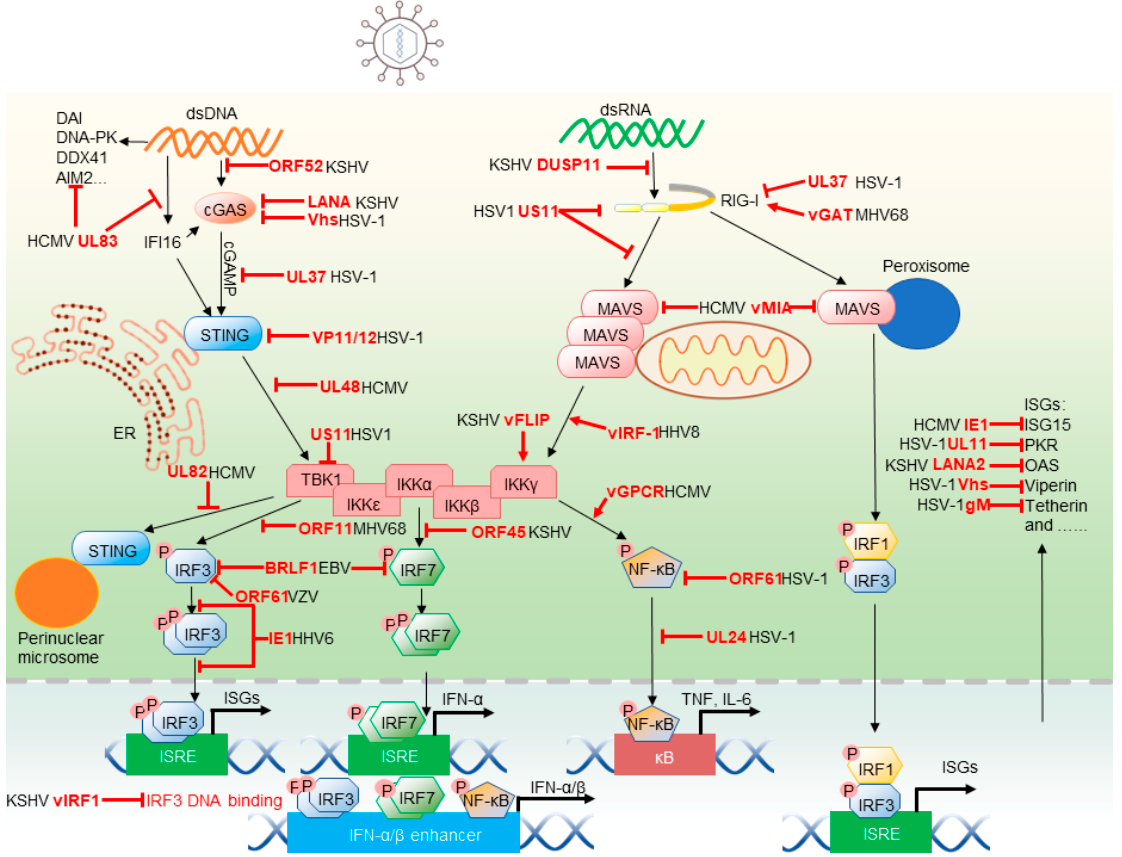
Figure 1. Herpesviruses modulate cytosolic pattern recognition receptors (PRR)-mediated innate immune signaling pathways. Upon herpesvirus infection, retinoic acid–inducible gene 1 (RIG-I) and